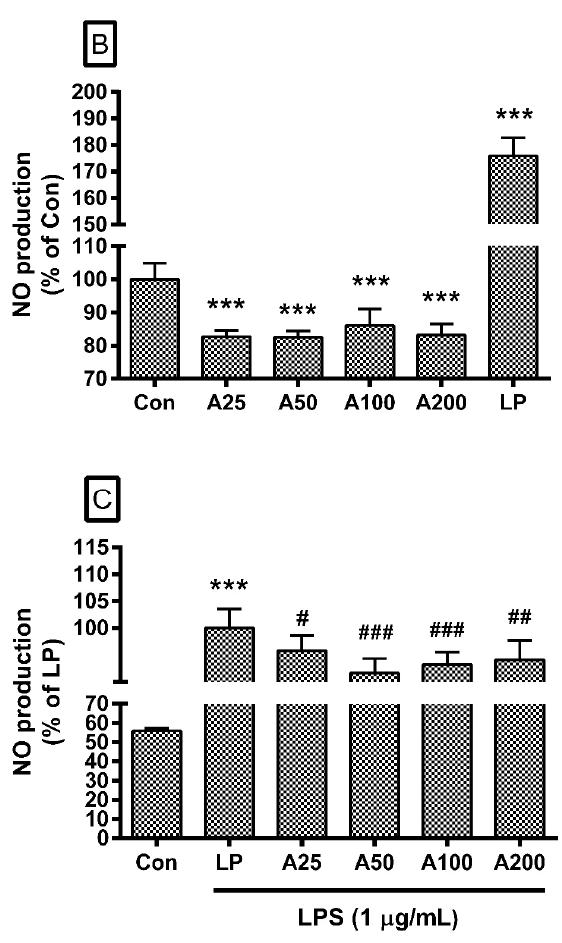
1 Figure 1. Effects of Angelica sinensis root water extract (ASW) on cell viability ( A ) and nitric oxide (NO) production ( B , C ). Cells were treated for 24 h. Con means the group treated with media